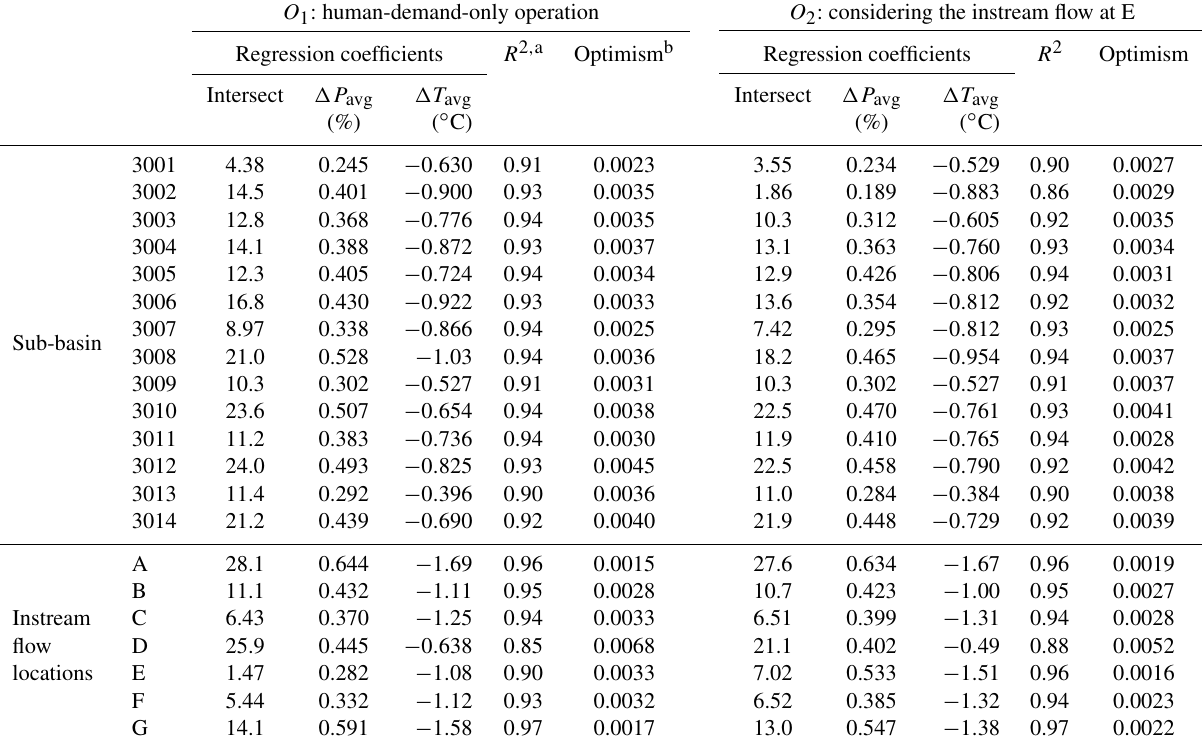
Table 2. The summary of logistic regressions and internal validations. The explanatory variables were statistically significant ( p val- ues < 10 − 3 ) for all the regression models.